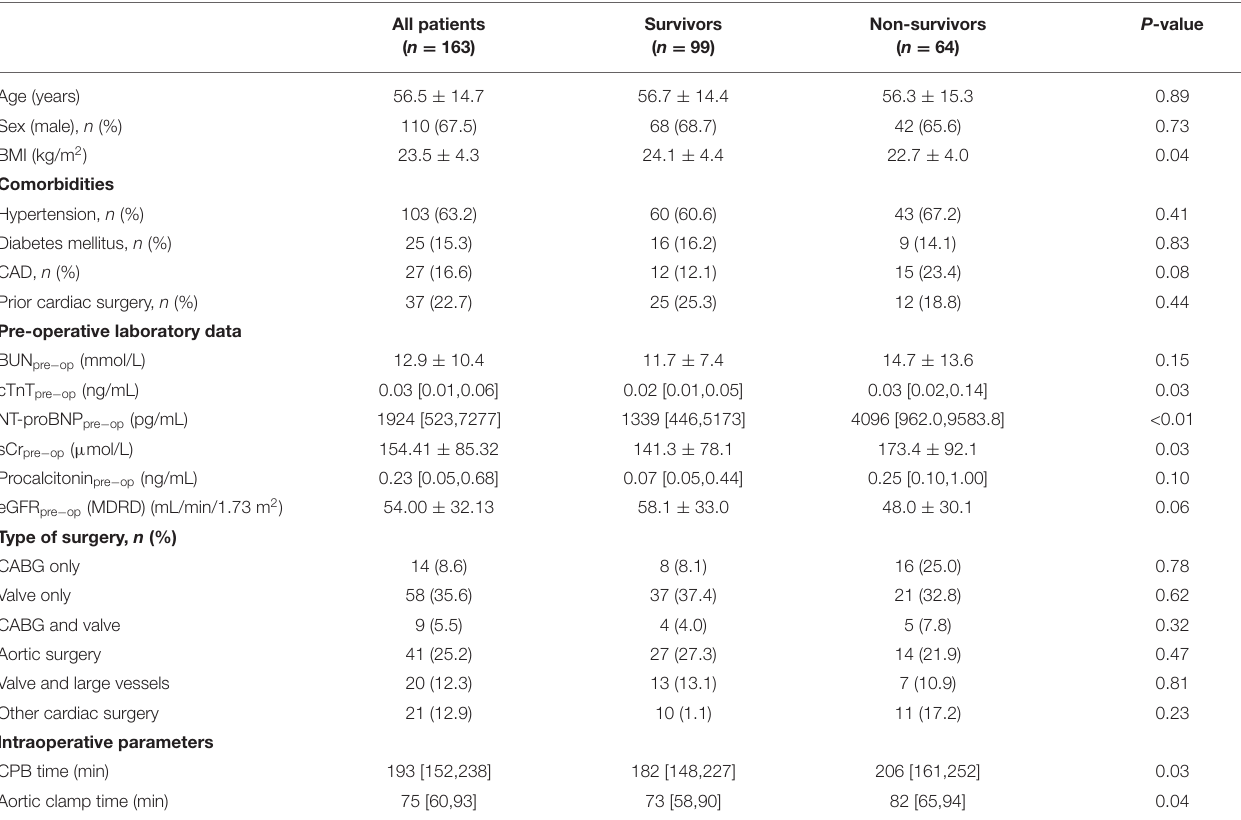
TABLE 1 | Clinical characteristics of patients grouped by 28-day mortality.